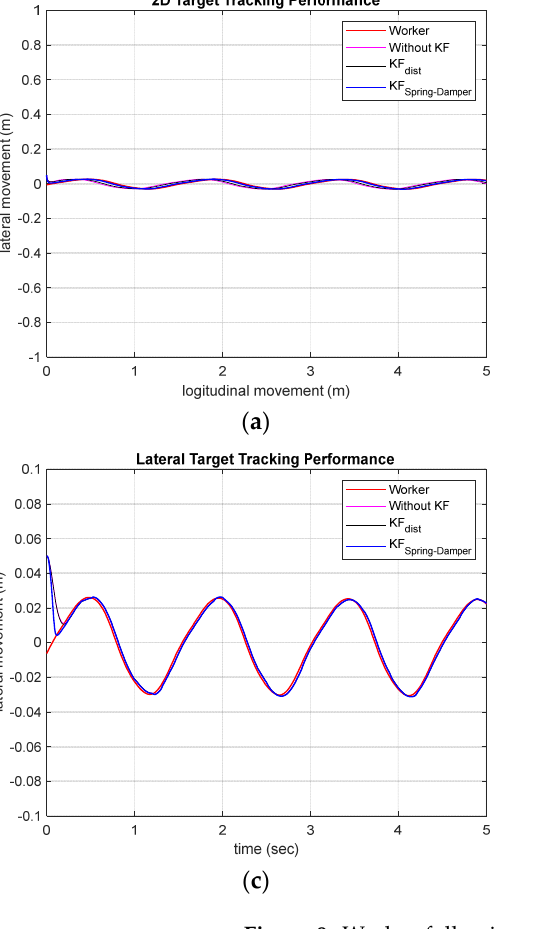
Figure 9. Worker-following performance: ( a ) 2D plane worker-following performance; ( b ) Longitu- dinal direction performance; ( c ) Lateral direction performance; ( d ) Target-tracking performance (relative distance).